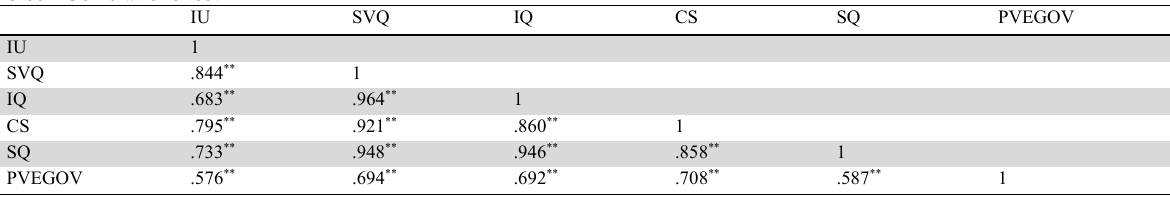
Person Correlations test